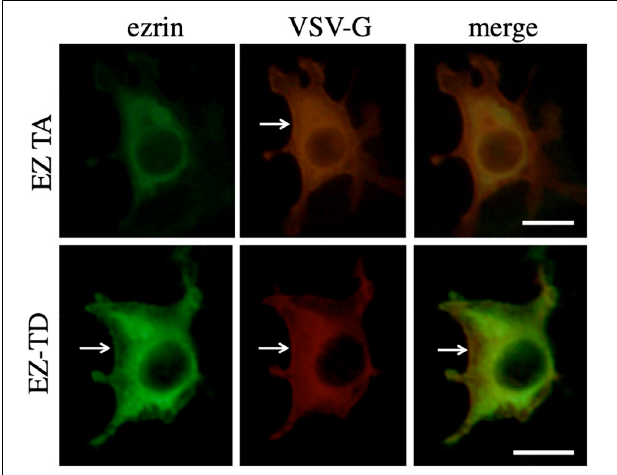
FIGURE 8 | Cellular localization of VSV-G with EZ-TA or EZ-TD. COS7 cells were transfected with the VSV-G expression plasmid together with the EZ-TA or EZ-TD expression plasmid. The cells were stained with mouse anti-VSV-G and goat anti-ezrin antibodies, and then Cy3-conjugated anti-mouse IgG (red) and FITC-conjugated-anti-goat IgG (green) antibodies. Scale bar is 10 µ m. White arrows indicate cell surface.